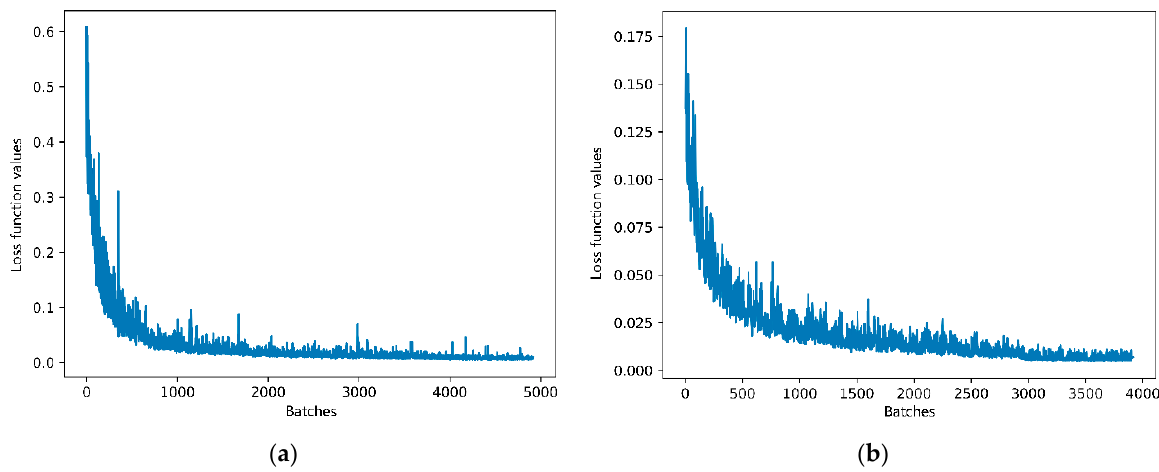
Figure 2. ( a ) The change of loss function values of YOLOv3 to train real TC images; ( b ) the change of loss function values of NDFTC to train real TC images.